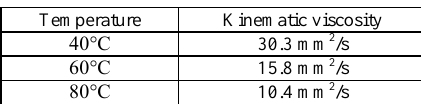
Table 2. Kinematic viscosities of experimental